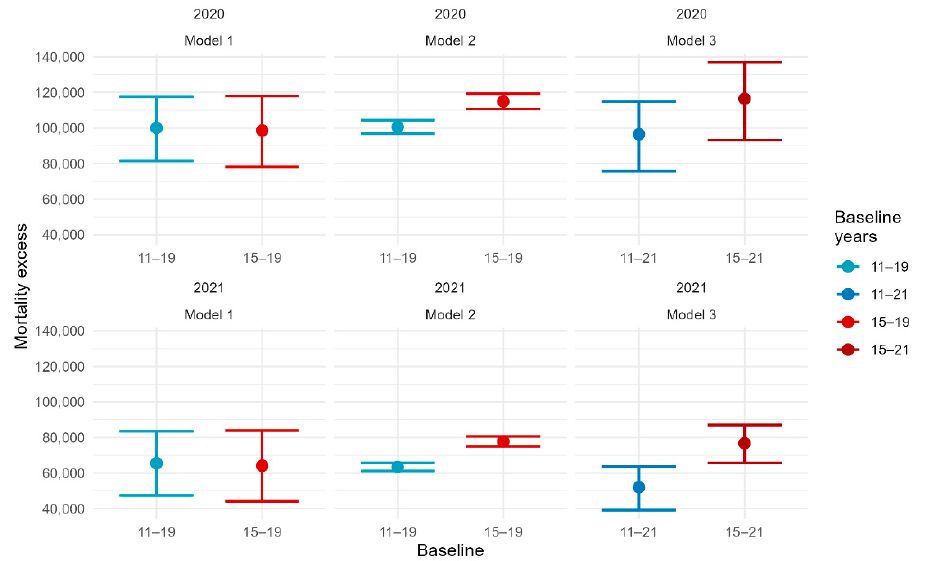
Figure 2. Comparison of the three models estimates using 2011–2019 and 2015–2019 as